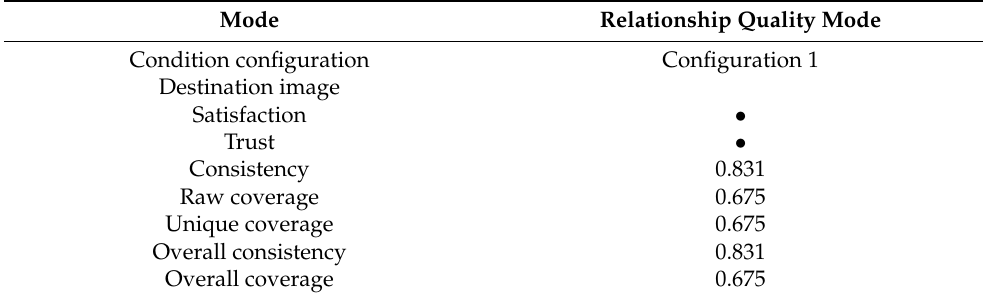
Table 17. Configuration analysis of high-level public pro-environmental